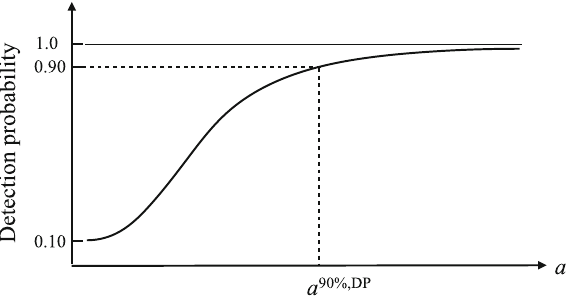
Fig. 4 Detection probability as a function of the signal amplitude for a false alarm probability equal to 10%. The value of a needed for 90% detection probability is indicated by the dashed vertical line and is denoted by a 90% , DP